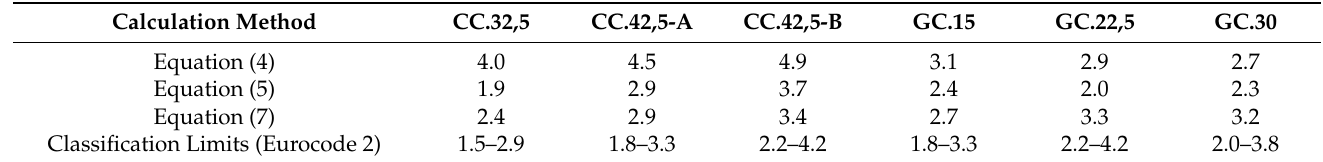
Table 8. Tensile strength (MPa) of CC and GC. Classification limits (Eurocode 2).